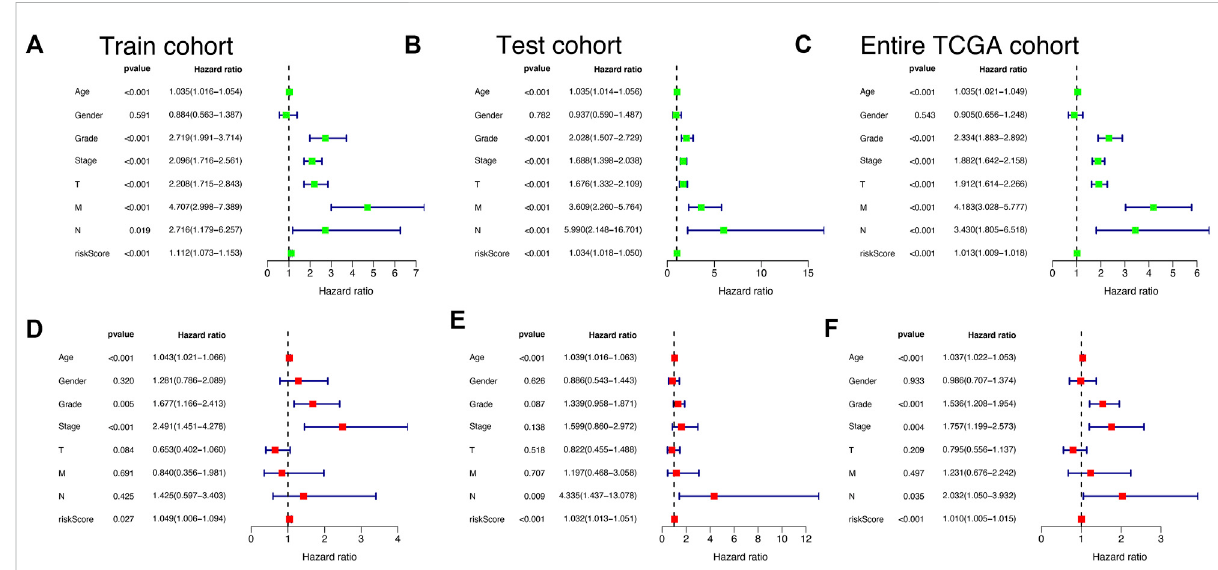
FIGURE 6 Independent prognostic validation of risk signatures. Univariate and multivariate Cox regression analysis results were presented in the form of forestplots,indicating thatrisksignaturewasanindependentprognosticfactorforKIRCpatientsinTraincohort (AandD) ,Testcohort (BandE) ,and Entire TCGA cohort (C and F)